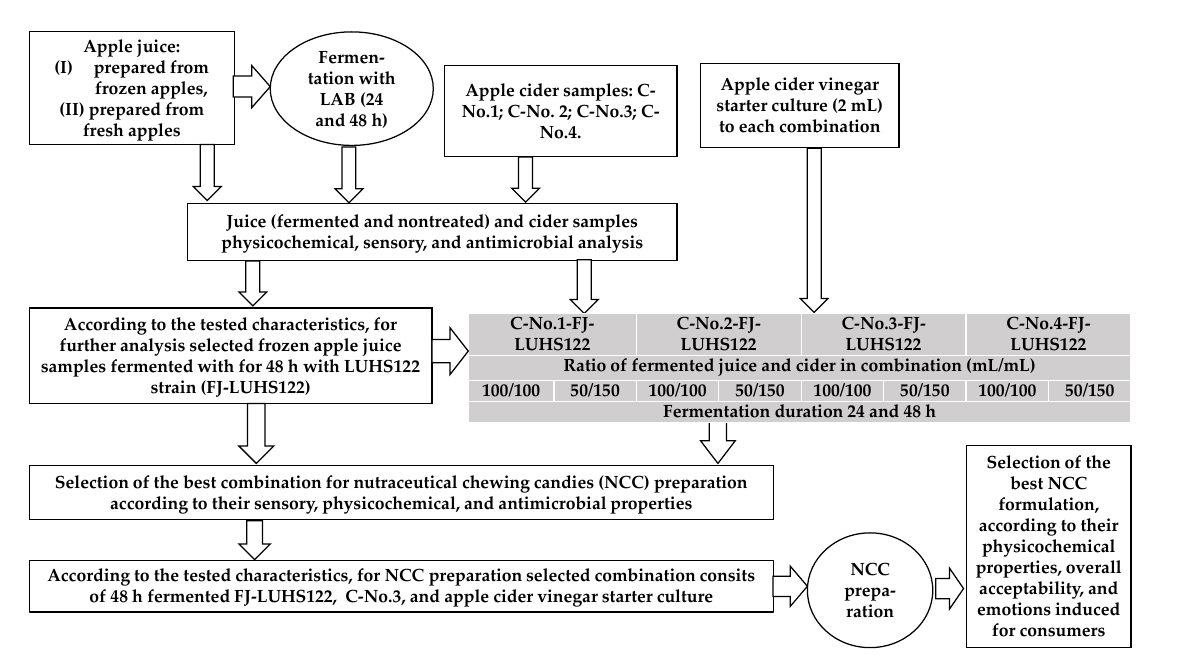
Figure 1. Principal scheme of the